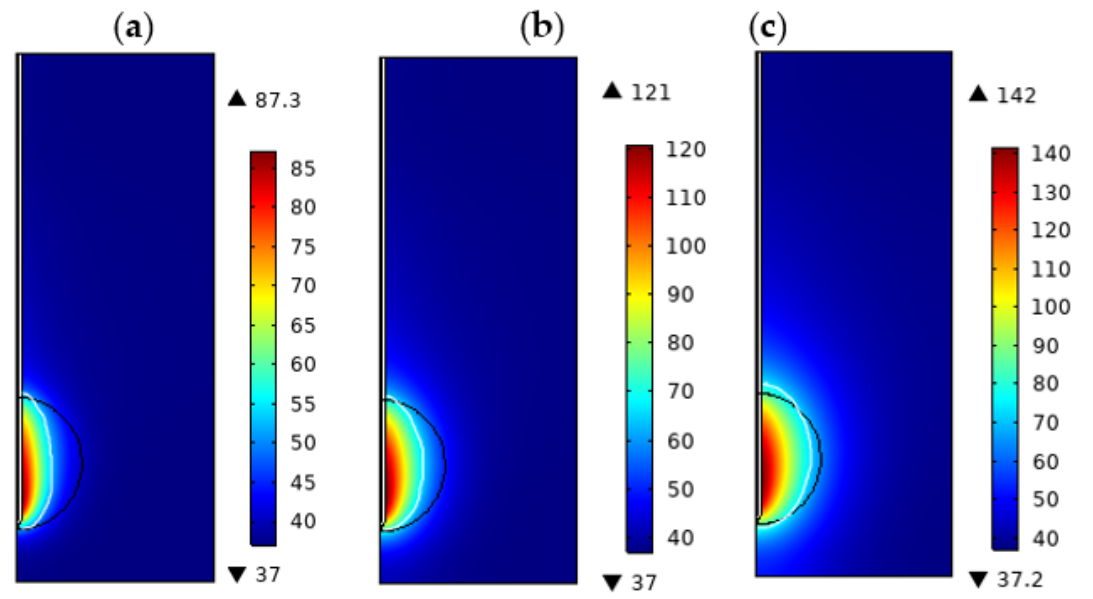
Figure 5. Temperature distribution of porous lung tissue at different ablation powers. (t = 300 s, d φ = 0.6, = 2.0 cm, t Table 7. Ablation temperature, ablation area and ablation volume at different ablation